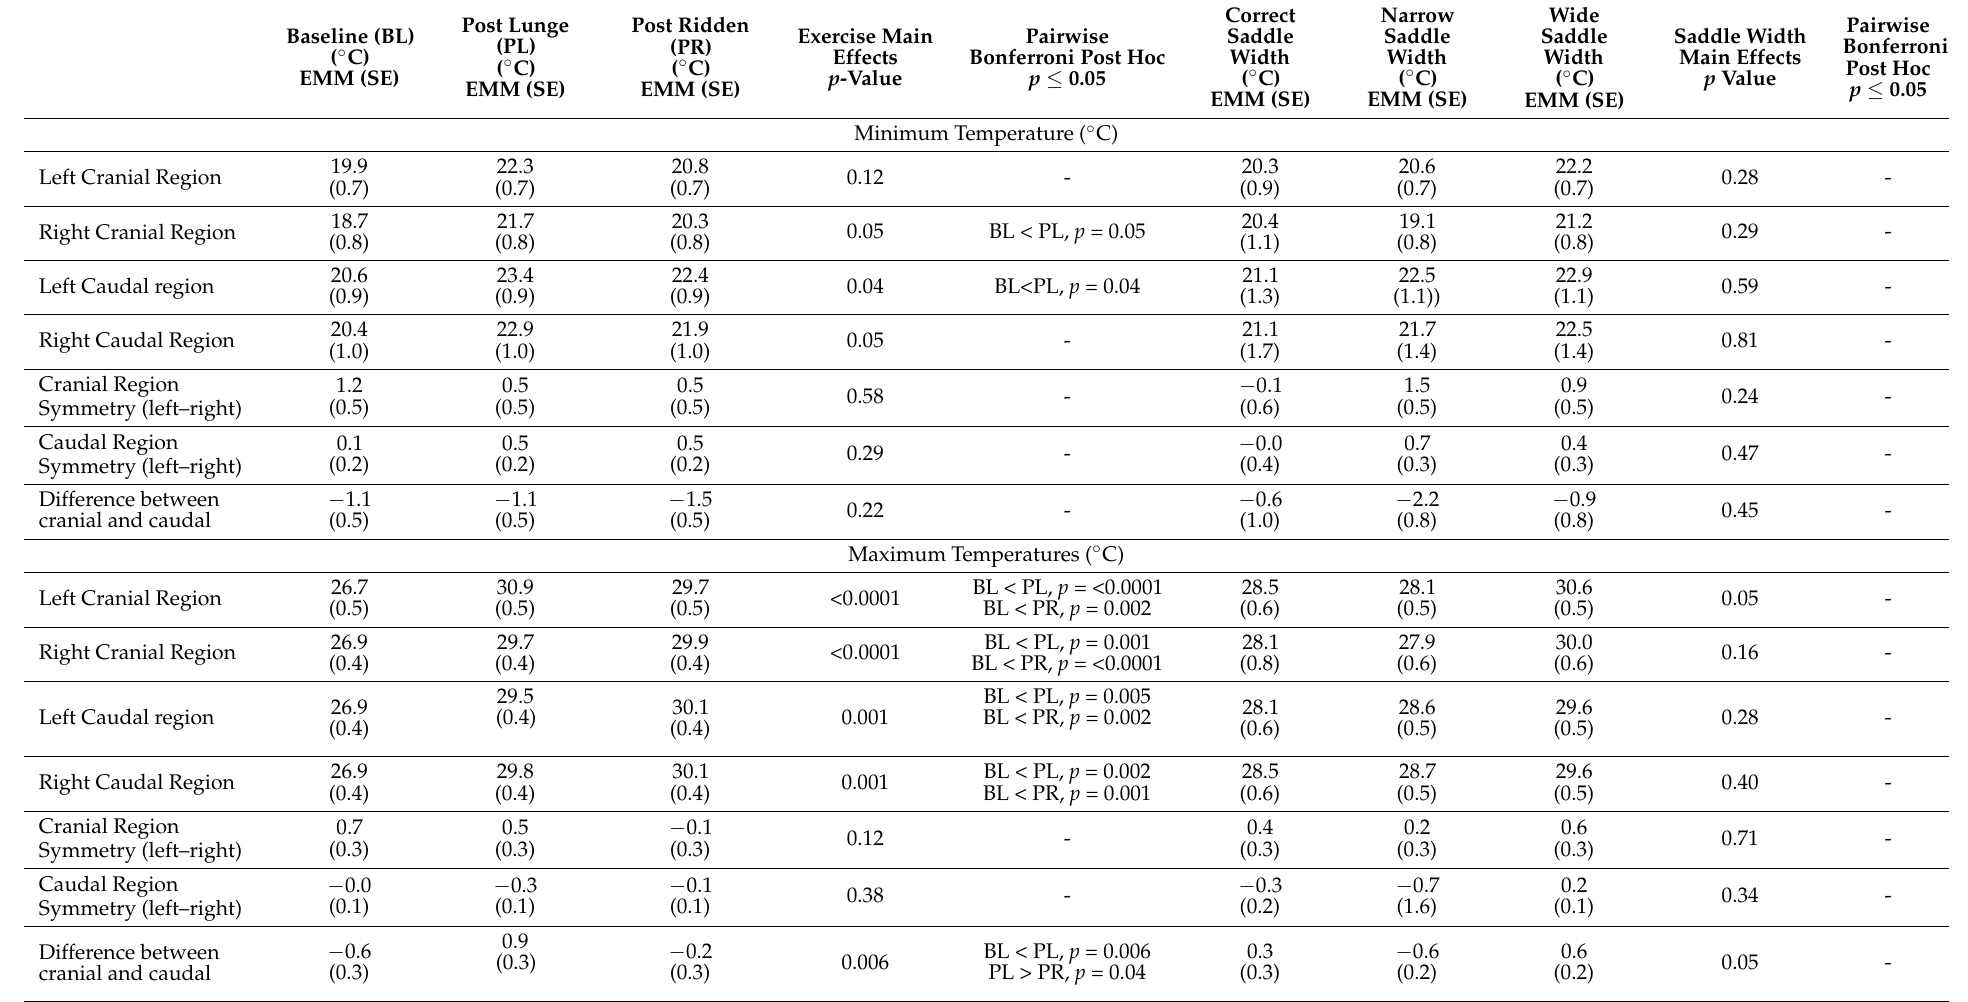
Table 1. Minimum, maximum and mean thermal temperatures of the cranial and caudal regions of the thoracic spine. EMM: Estimated marginal means; SE: standard